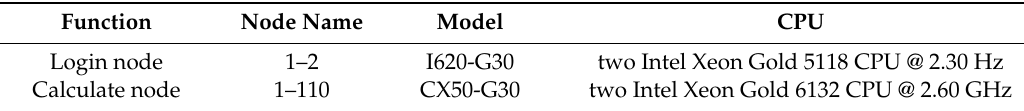
Table 3. The specific configuration of High Performance Computer.